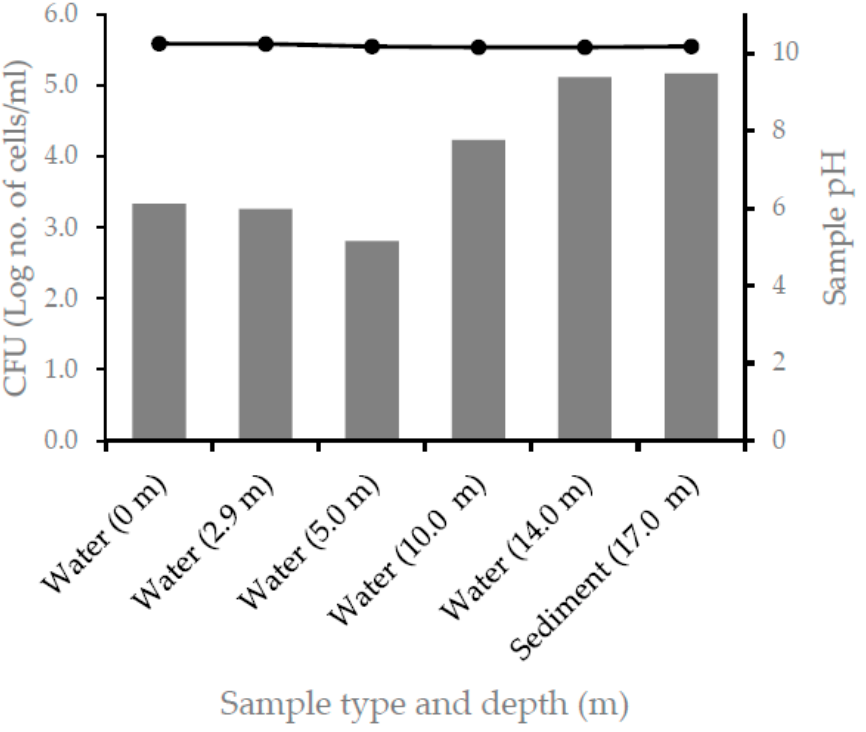
Figure 1. Colony-forming units (bar graph) from enrichment culture in a nitrogen-free media inoculated with samples collected from different depths. The pH of the samples taken from each depth is also shown with the line graph.